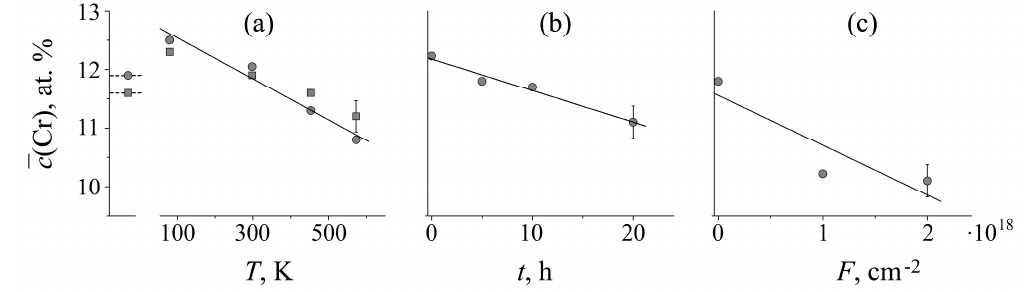
Figure 3. ( a , b ) The dependence (and ( c ) a tendency) of c ( Cr ) in the matrix of the alloys ( a ), ( b ) Fe 86.8 Cr 13.2, and ( c ) Fe 88 Cr 12 on the temperature of HPT, duration of ball milling (BM), and fluence of electrons at 423 K. Round symbols correspond to the values for the state “annealed at 1073 K (as-received)”; square symbols, for the state “annealed at 773 K, 50 h (aged)”.